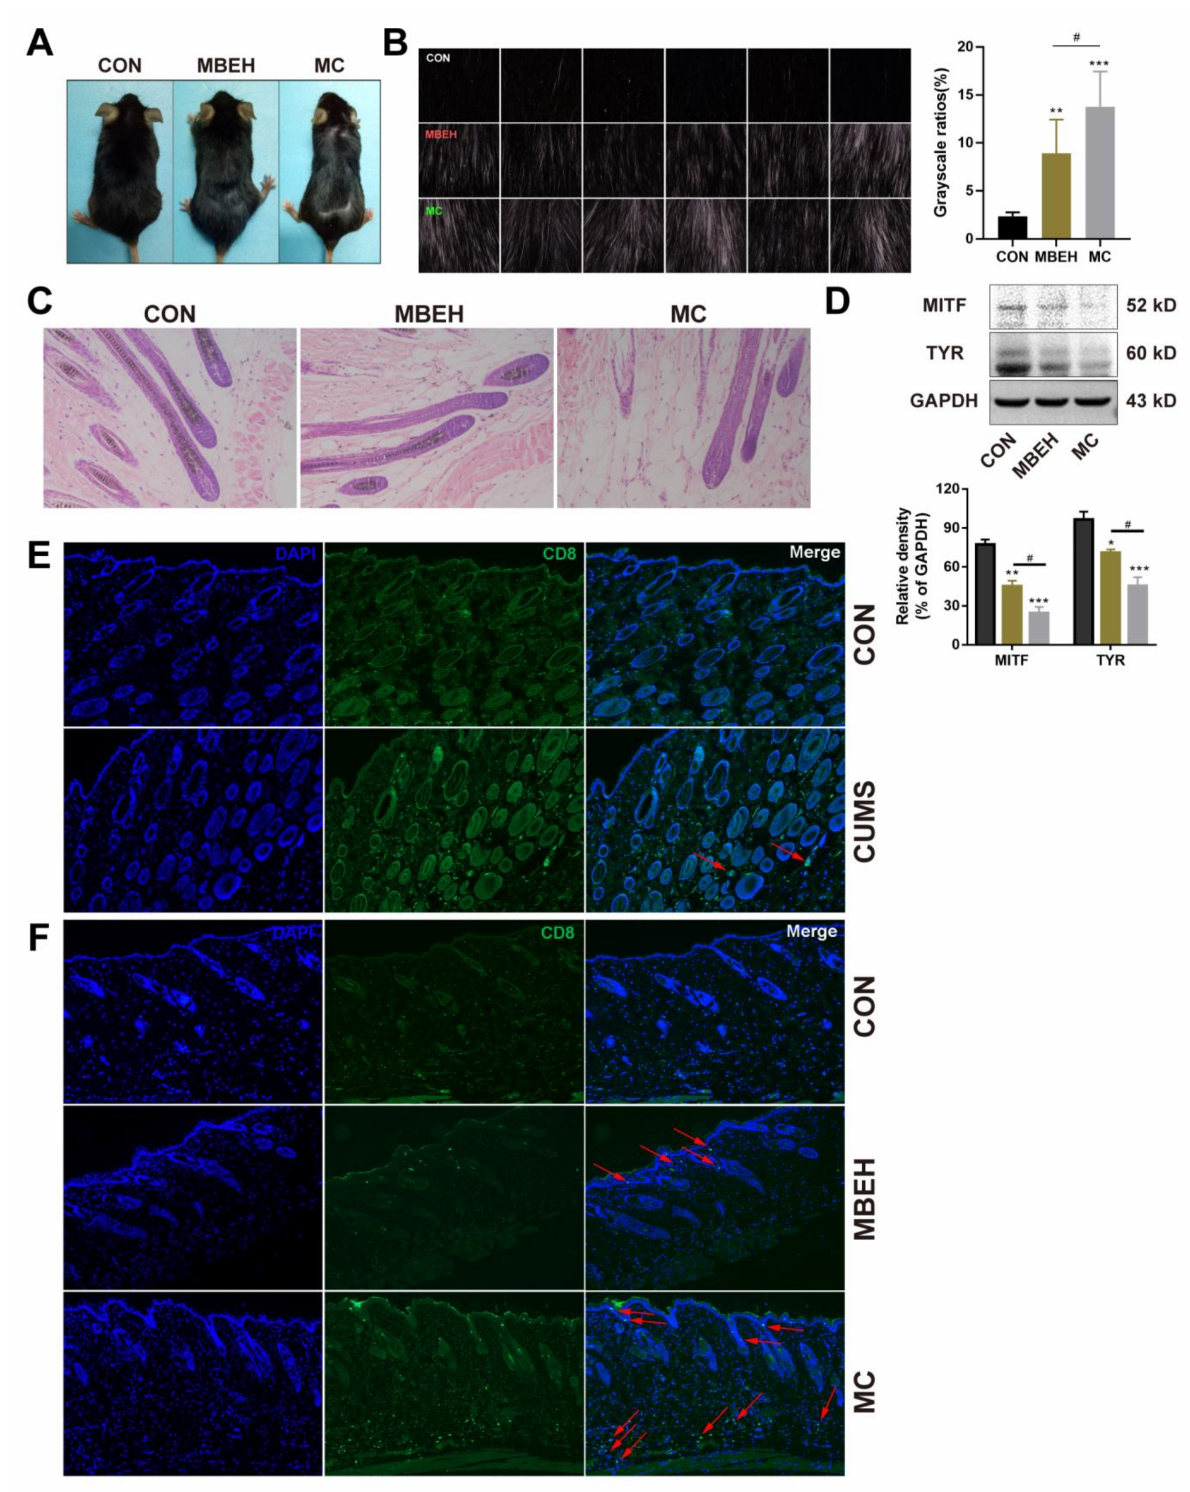
Figure 3. MBEH and MC inhibit skin melanogenesis. ( A ) Effects of MBEH and MC on melanin synthesis in the back skin of mice. ( B ) Effects of MBEH and MC on depigmentation of mouse dorsum. The phenotype of deep-layer hair pigment taken by the MPA 580 system in the modeling area on the mouse dorsum. Magnification: 10 × . The grayscale was scanned by ImageJ to document the appearance of CON, MBEH and MC. ( C ) H&E staining of the mouse skin. Magnification: 200 × . ( D ) The protein level of MITF and TYR were determined by Western blot analysis (n = 6). ( E , F )